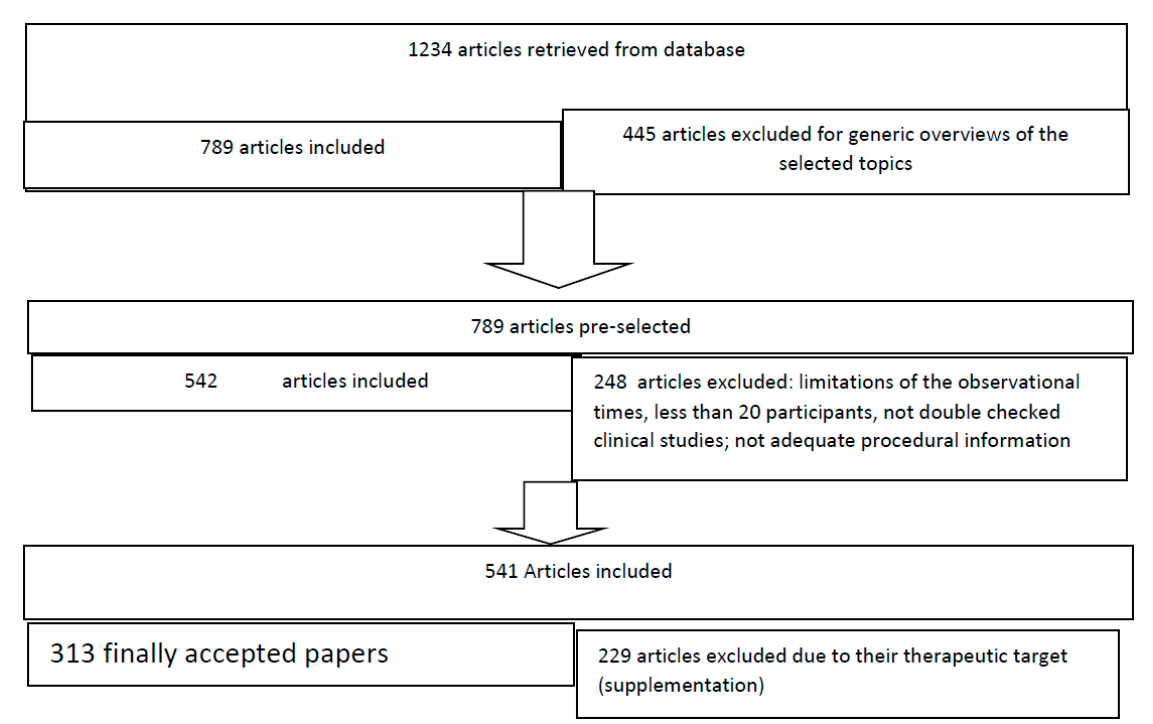
Figure 1. Flowchart of search strategy and selection criteria.